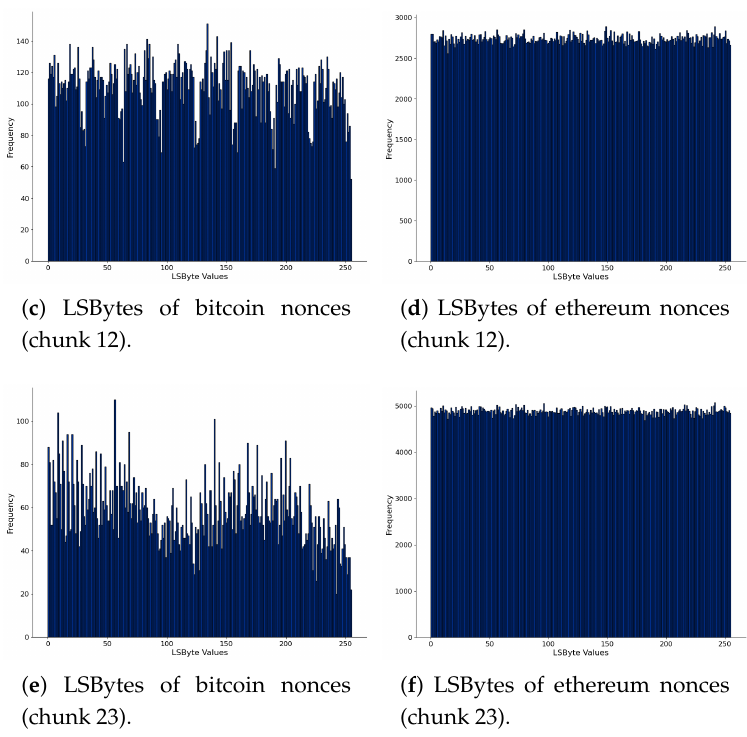
Figure 4. Comparison of LSBytes of nonces of bitcoin ( left ) and ethereum ( right ), considering the first and the last chunk of parsed blockchain data.